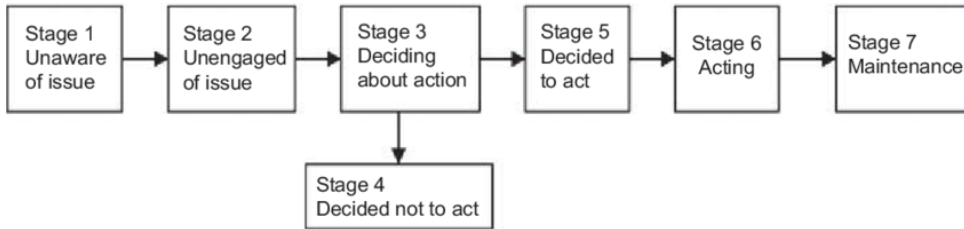
Figure 1. The Relation of IBM Constructs and Behavioral Intention to Register as an Organ Donor.